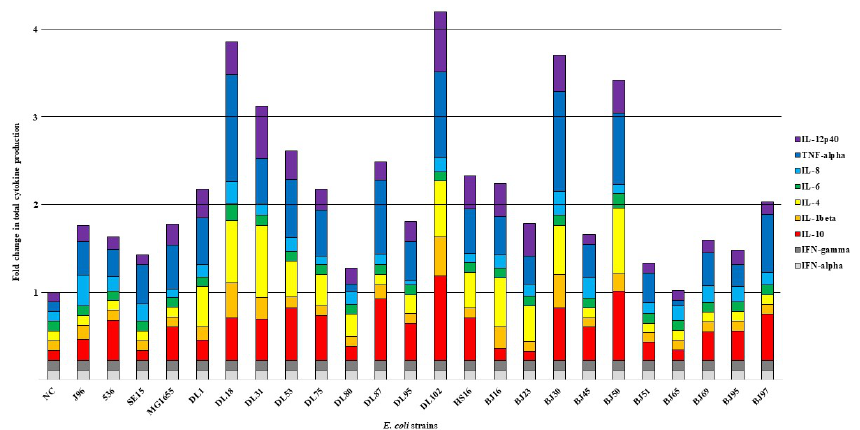
Figure 1. Fold change in total cytokine production by NPU cells in response to infection with different E. coli strains relative to the value of cytokine production in the negative control (NC), (NC—negative control, not infected NPU cells). The experiment was performed in duplicates, fold change for each cytokine was calculated by dividing the average value of the concentration of each analyte measured by the instrument from both duplicates in the E. coli infection assay with the average value of both duplicates in the negative control.